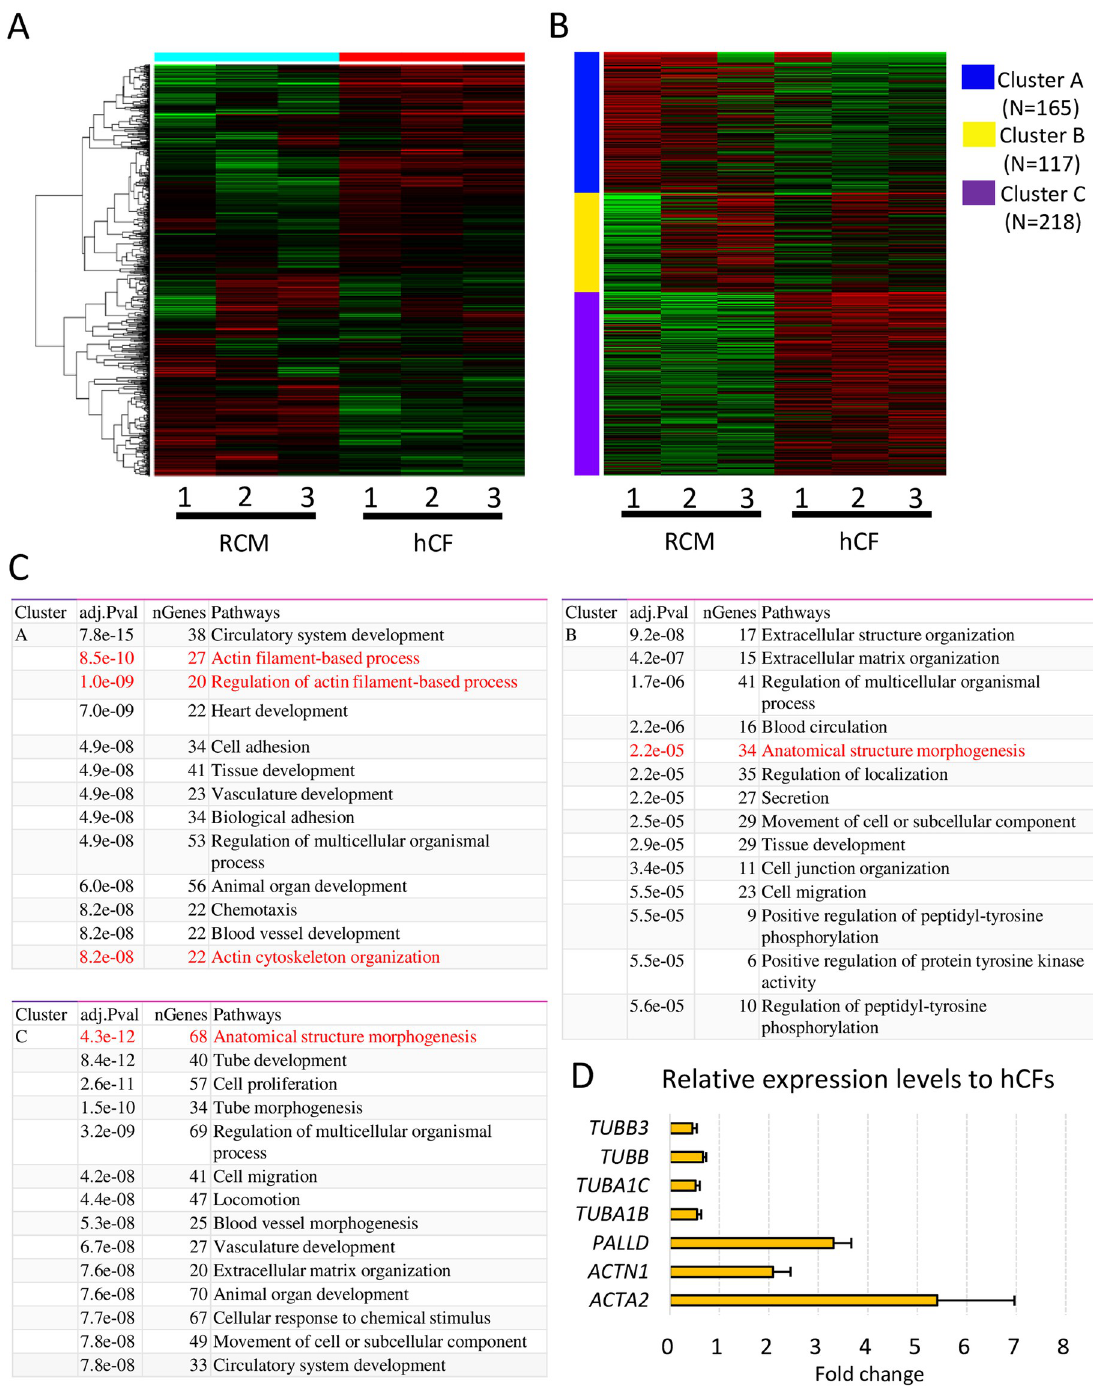
Fig 3. RNA-sequencing analyses of cardiac fibroblasts (CFs). (A) Hierarchical clustering of top 1000 genes between restrictive cardiomyopathy (RCM) and healthy control CFs (hCF). (B) K-means clustering of RCM CFs and hCFs. (C) Pathway analyses of K-means clustering indicate that actin filament-associated processes and anatomical structure morphogenesis are affected in RCM CFs. (D) Differential gene expression analysis revealed that expression levels of several genes associated with the cytoskeleton and cell adhesion are significantly up- or down-regulated in RCM